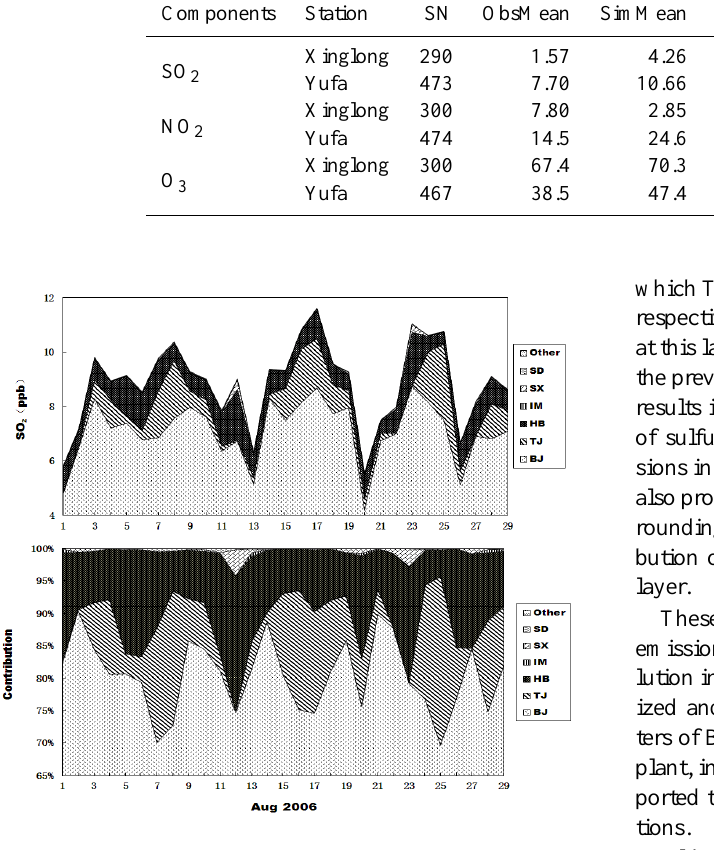
Fig. 5. Time series of the contributions to the daily mean SO 2 concentration (top) over Beijing at the surface layer and its percentage (bottom). Beijing (BJ); Tianjin (TJ); Hebei (HB); Inner Mongolia (IM); Shanxi (SX); Shandong (SD).